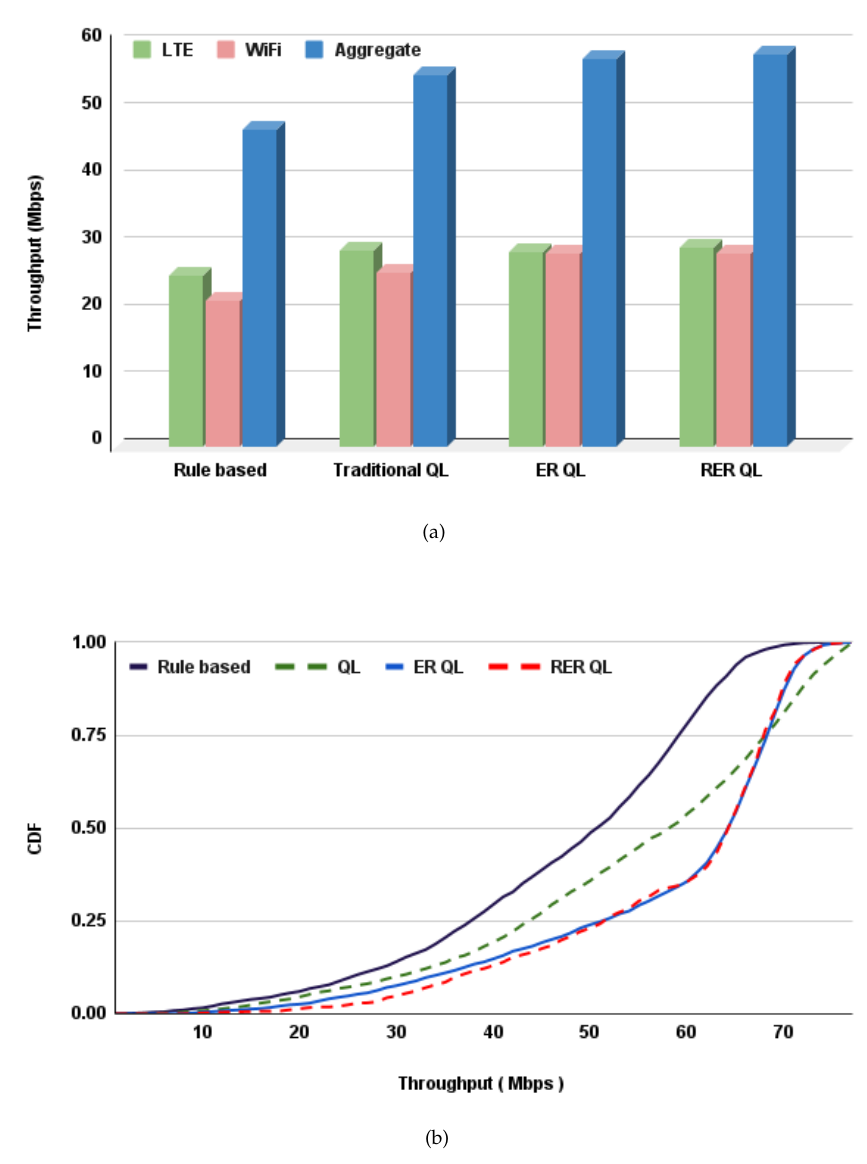
Figure 4. Comparison of aggregated throughput for the proposed solutions ( a ) average aggregated throughput ( b ) CDF of aggregated